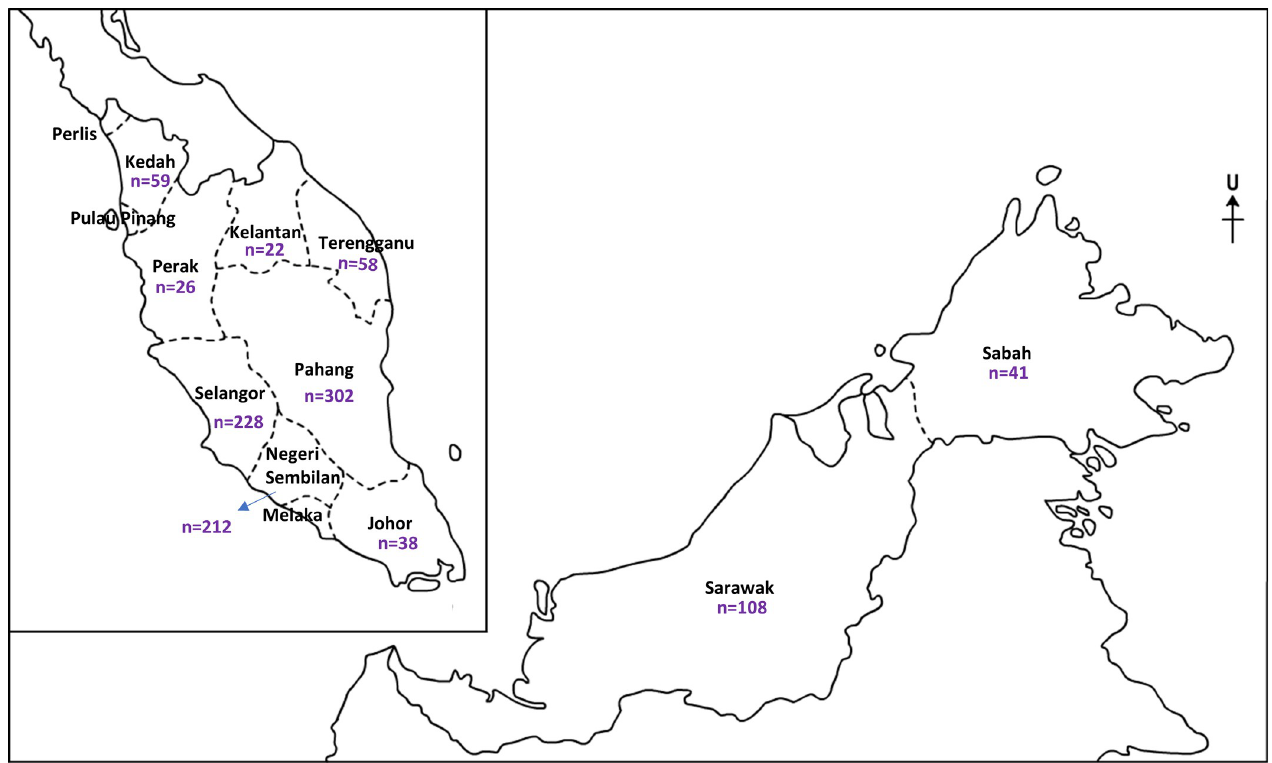
Fig 2. The map of Malaysia (Peninsular and East Malaysia) together with the total number of samples collected in each state (Malaysia map is adapted from https://malaysiageography.blogspot.com/p/peta.html with permission from the owner).